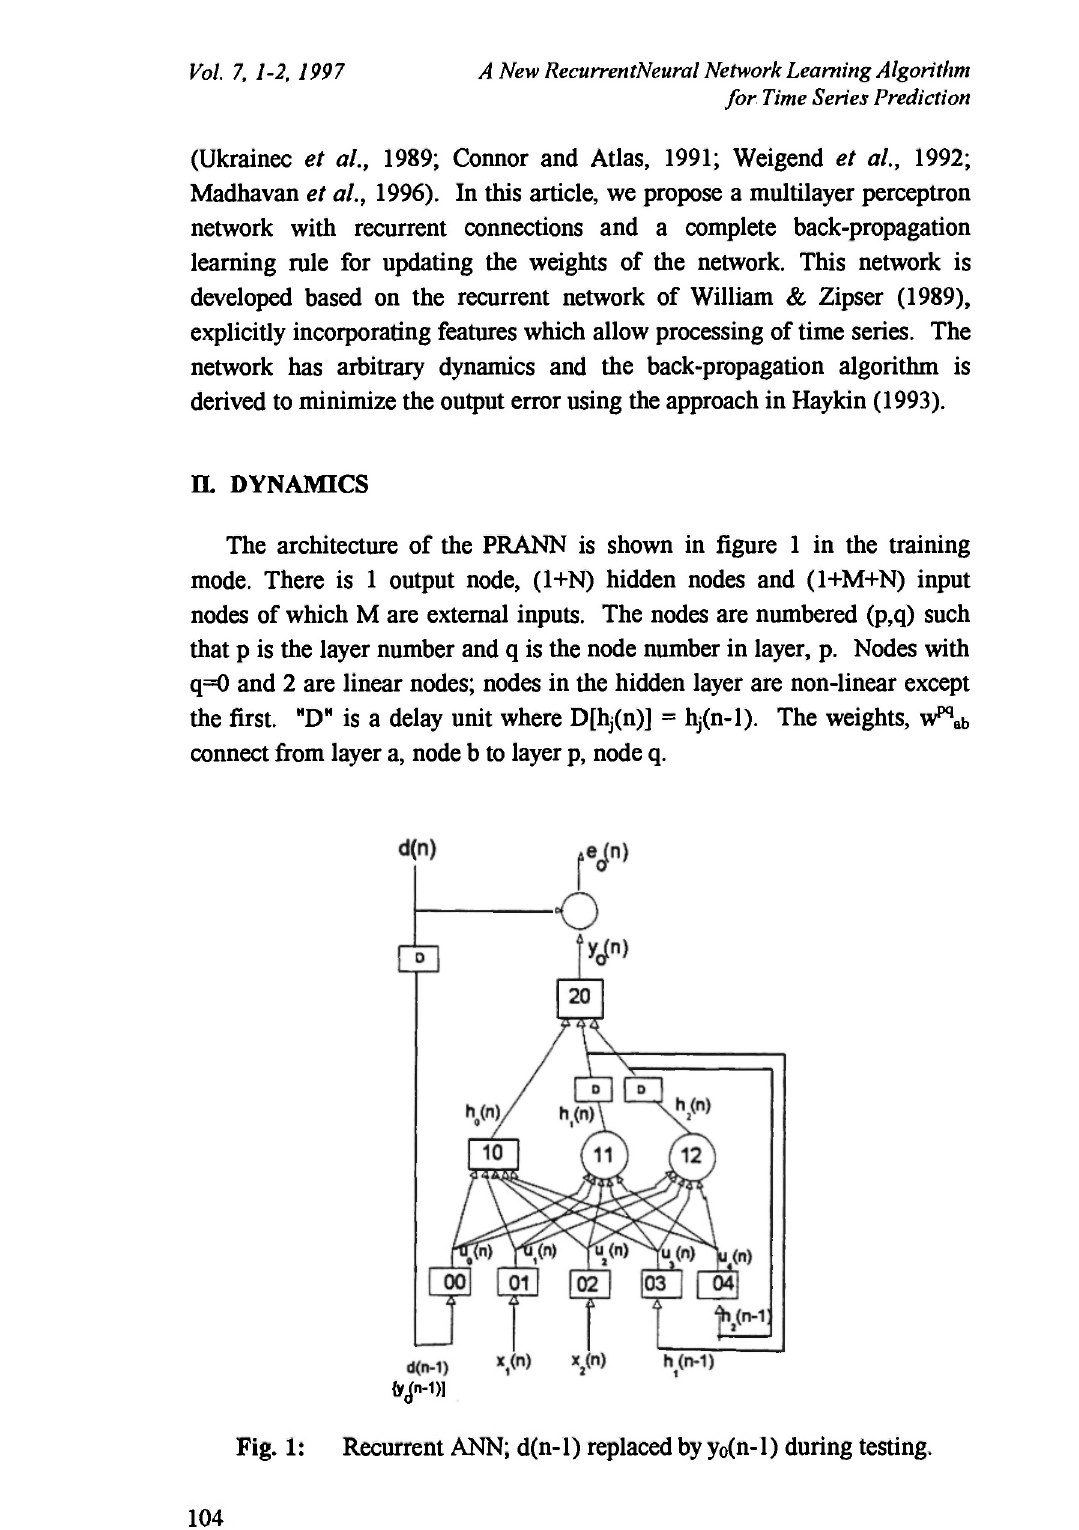
Fig. 1: Recurrent ANN; d(n-l) replaced by yo (n-l) during